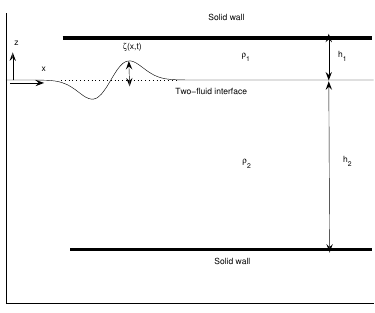
Figure 1. A typical internal wave propagating in a two-fluid system. The rest level of the system is indicated with a dashed line. The system of two layers considered is constrained to a region limited by horizontal rigid lids located at the top and at the